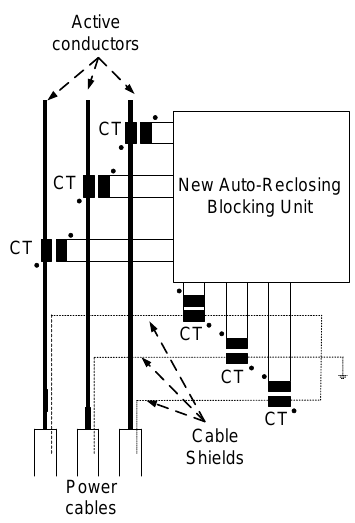
Figure 6. Currents of the cables measured in the active conductors and their shields.